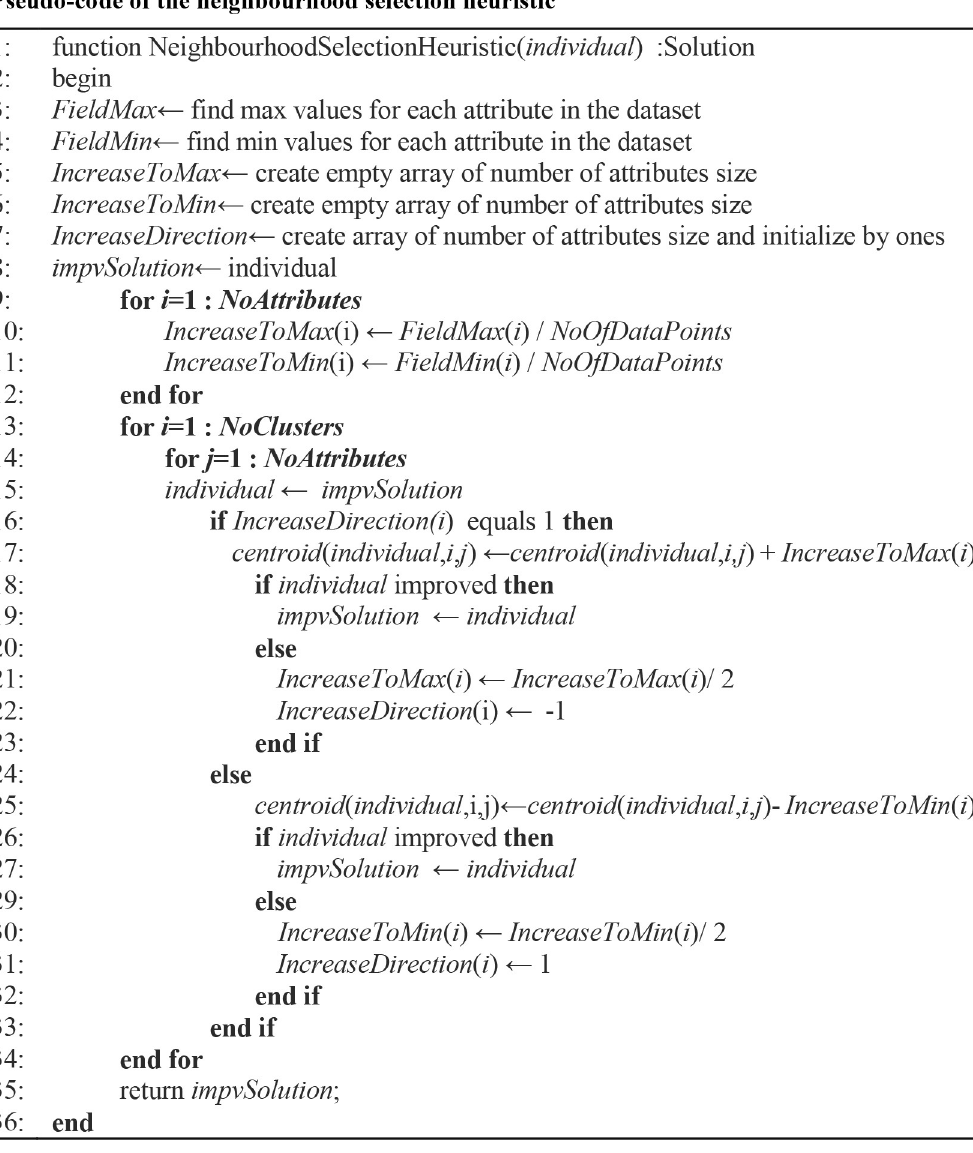
Fig 9. Pseudo-code of the neighbourhood selection heuristic